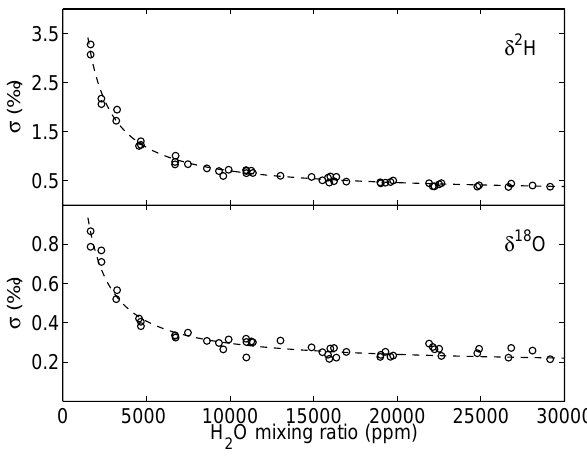
Fig. 4. Response time of a step change (at t =0s) when inlet air is switched from sample to calibration at a flow rate of 800mLmin − 1 for δ 2 H (top), δ 18 O (middle) and H 2 O (bottom). The time lag after the switch is ∼ 4s and the time constant of the exponential change is ∼